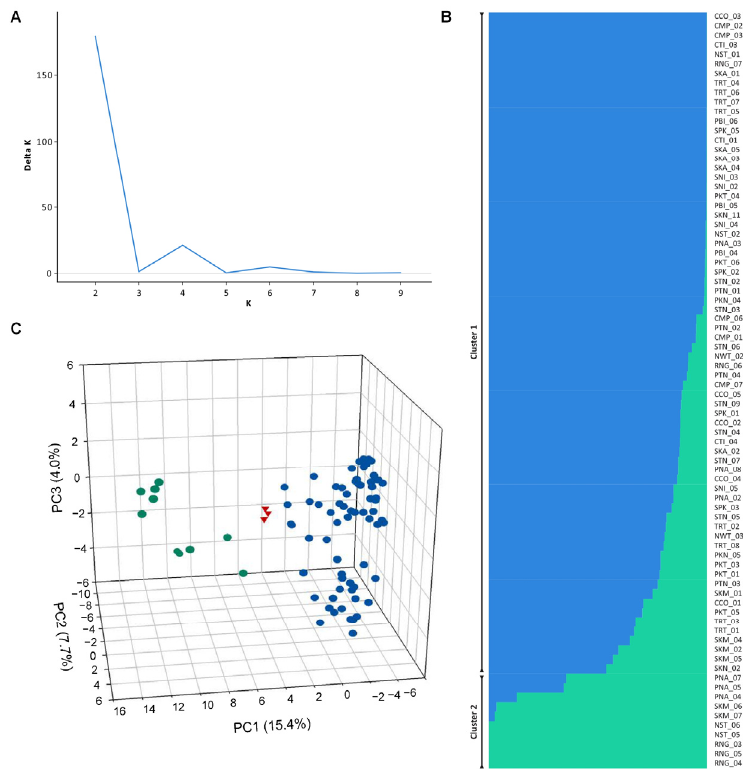
Figure 3. Population structure of 80 R. mucronata accessions using 2857 SNP markers inferred by STRUCTURE program. ( A ) Number of subpopulations indicated by the highest ∆ K. ( B ) Proportion of clustering of individuals to two clusters. Each bar represents one accession. Blue and green colors within each bar indicate admixture among samples collected from the Andaman and Gulf of Thailand coast. ( C ) Distribution of 80 R. mucronata accessions on a scatter plot based on PC1, PC2, and PC3 from principal component analysis (PCA). The accessions are colored according to the two STRUCTURE clusters. The red triangles indicated the admixture accessions.